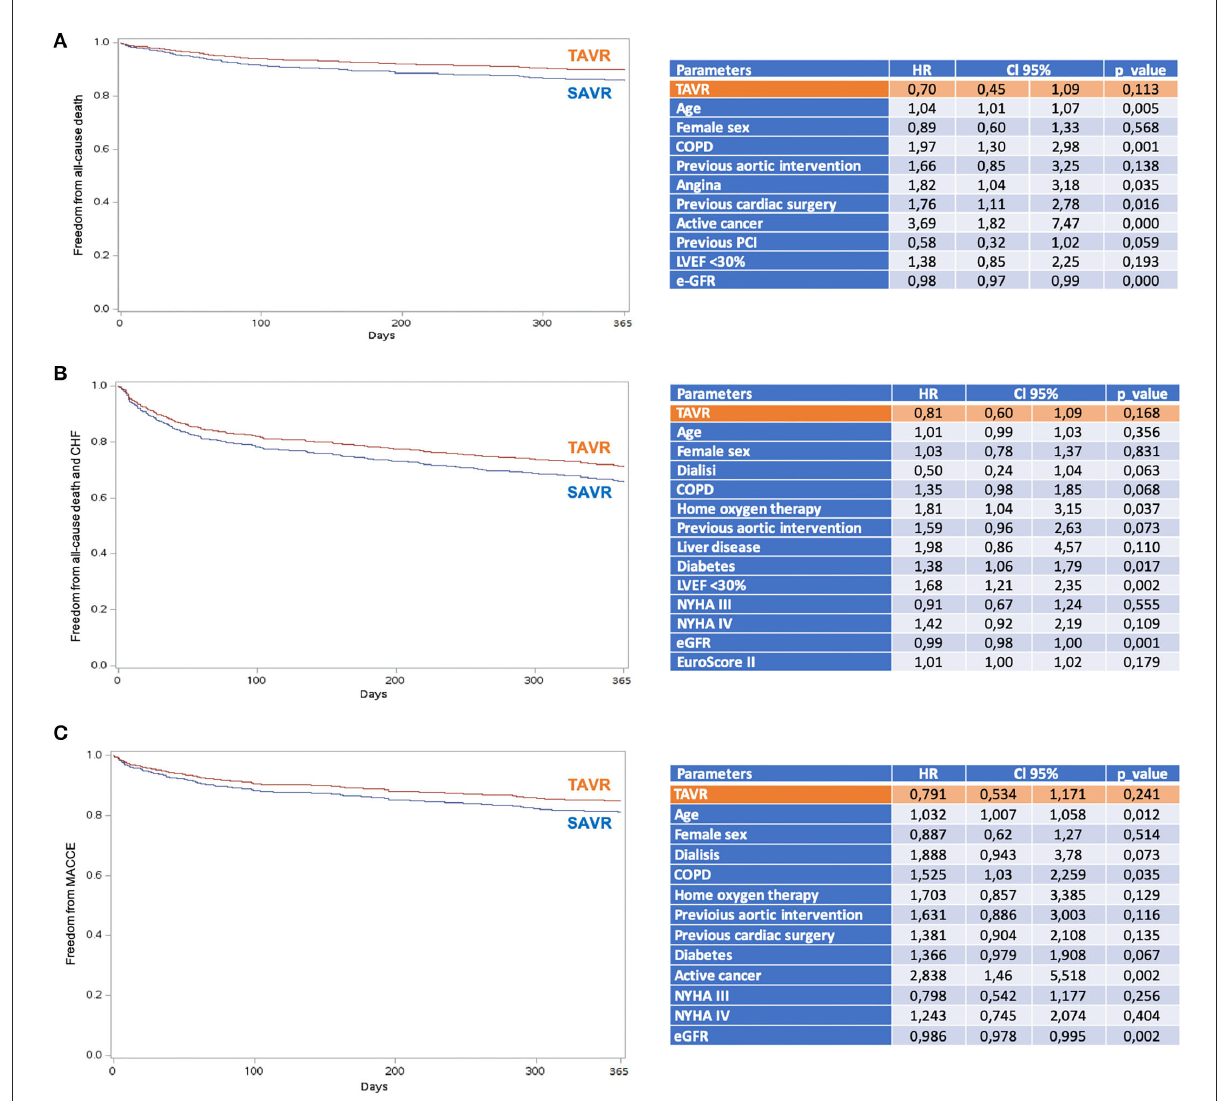
FIGURE5 Adjusted proportional hazards estimates of outcomes after TAVR and SAVR. (A) Survival; (B) Survival freedom from the composite of mortality and hospital rehospitalization due to CHF; (C) Survival freedom from MACCE (all-cause mortality, stroke, myocardial infarction, and coronary revascularization). COPD, chronic obstructive pulmonary disease; e-GFR, estimated glomerular filtration rate; LVEF, left ventricular ejection fraction; NYHA, New York Heart Association; PCI, percutaneous coronary intervention; SAVR, surgical aortic valve replacement; TAVR, transcatheter aortic valve